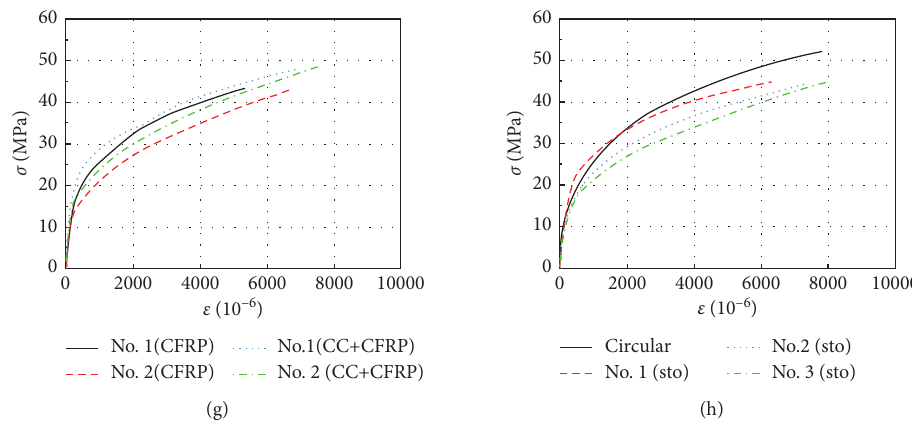
Figure 9: The stress-strain curves. (a) CFRP-reinforced column concrete surface. (b) CC and CFRP-reinforced column concrete surface. (c) CFRP-reinforced column fiber surface. (d) CC and CFRP-reinforced column fiber surface. (e) Strain difference between fiber and the concrete surface. (f) Strain at different positions on a square column. (g) Strain at different positions of the octagonal column. (h) Strain at different positions of the circular and the elliptical columns.